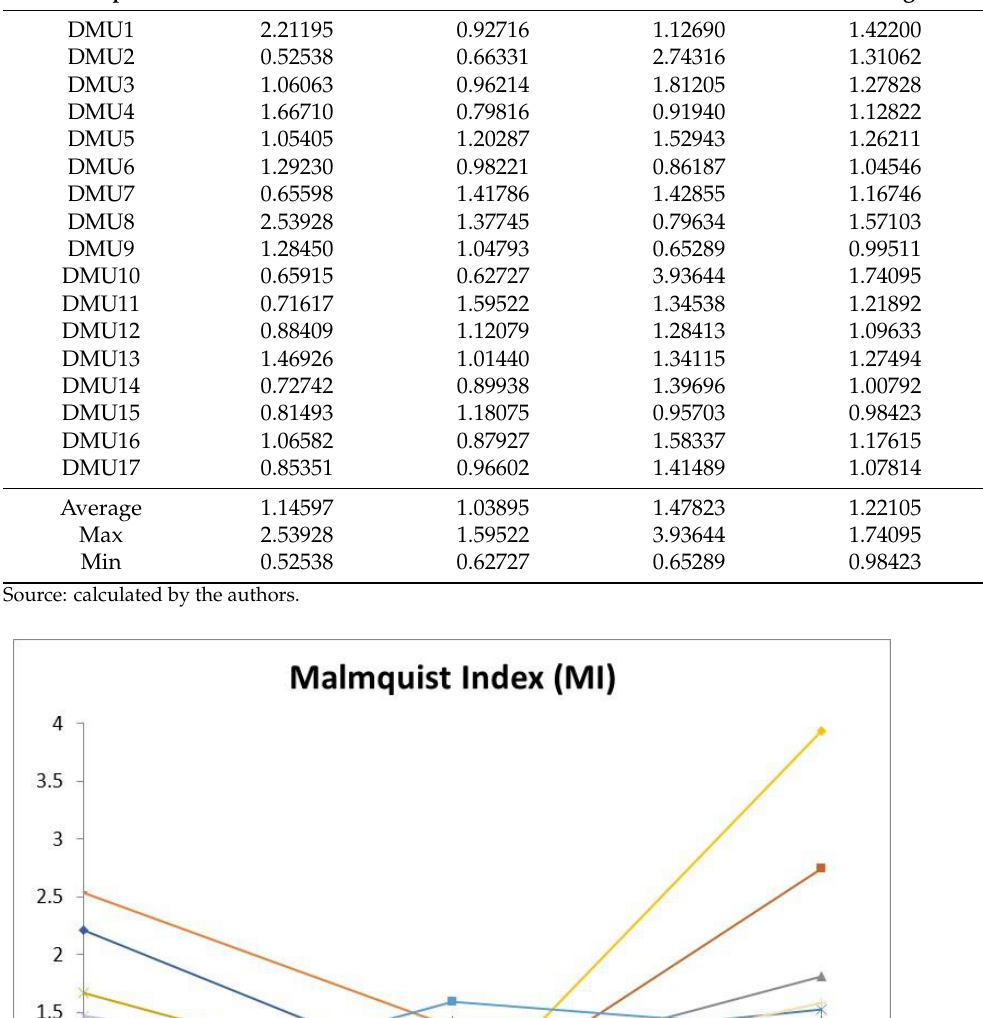
Table 8. Malmquist index (total productivity change).